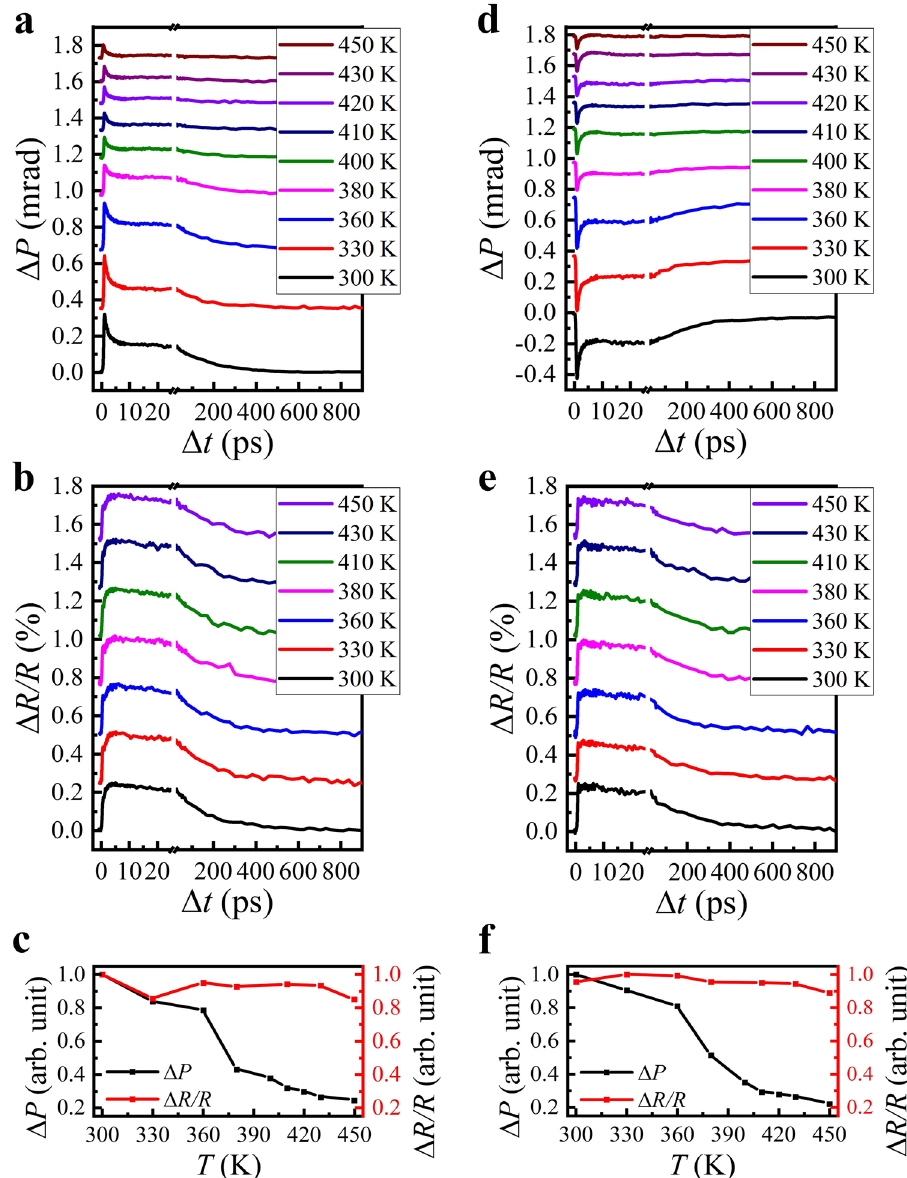
Fig. 3 Polarization and re fl ectivity dynamics over a temperature range of 300K-450K. Temperature dependence of a Δ P versus Δ t and b Δ R/R versus Δ t measured by s-polarized probe laser in Mn fi lm in the case of θ = 45°. c Temperature dependence of the dynamic curves peak of Δ P and Δ R/R . 3 Sn d – f As a – c , but in the case of θ = 135°.